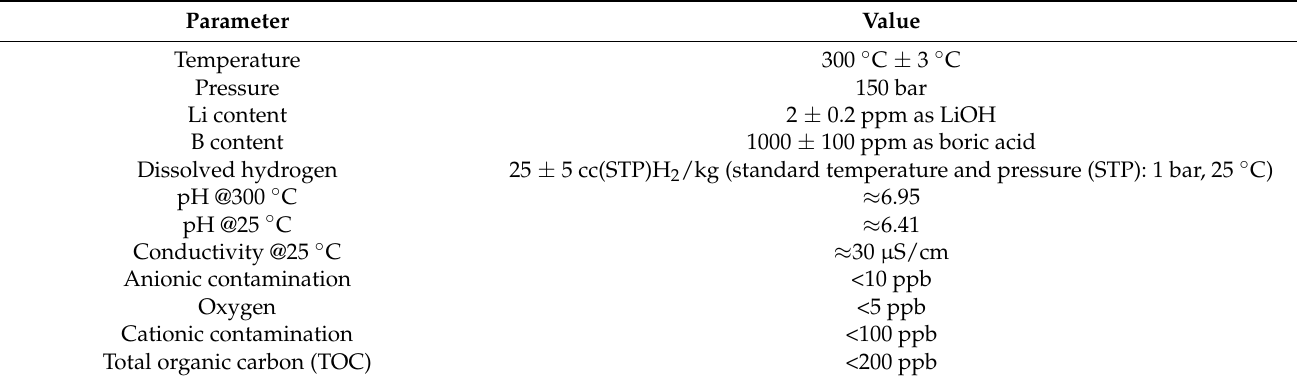
Table 3. Simulated PWR environment.